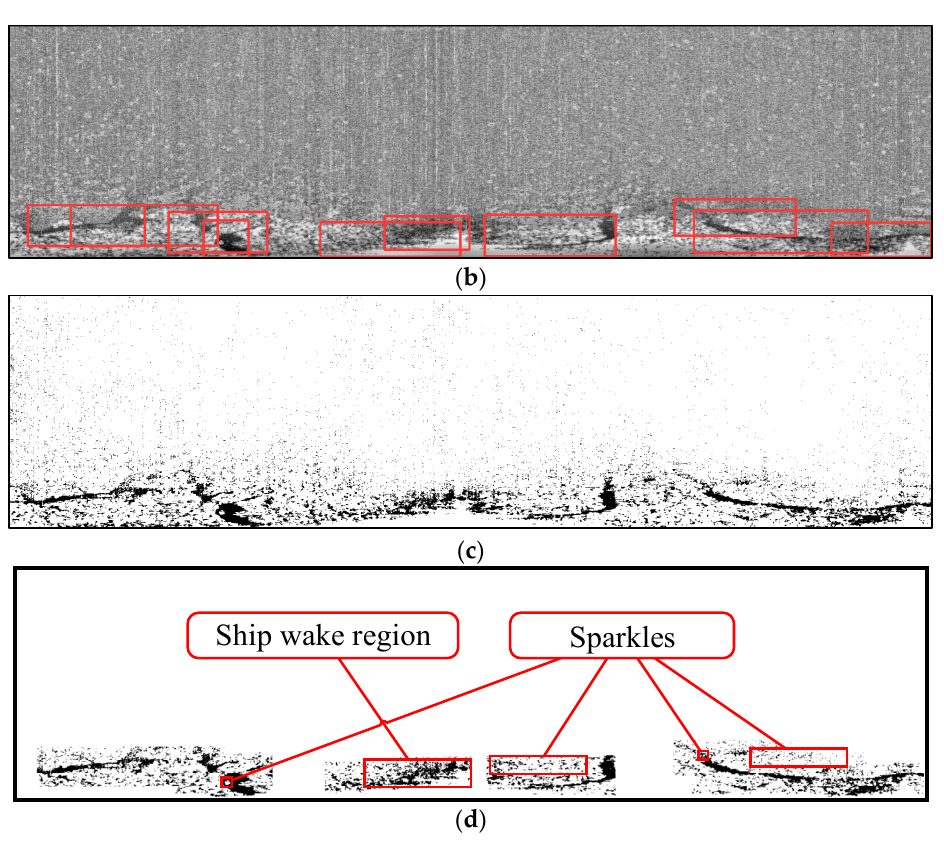
Figure 11. Oil spill preliminary identification. ( a ) The preprocessed marine radar image of Figure 1b; ( b ) The trained YOLO model detection result; ( c ) Saulova threshold segmentation; ( d ) Oil film preliminary segmentation.